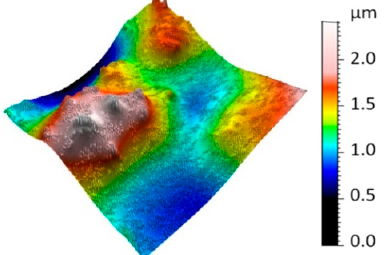
Figure 13. Topographic digital model of a nanometric scale region (10 by 10 µm) measured by atomic force microscopy.